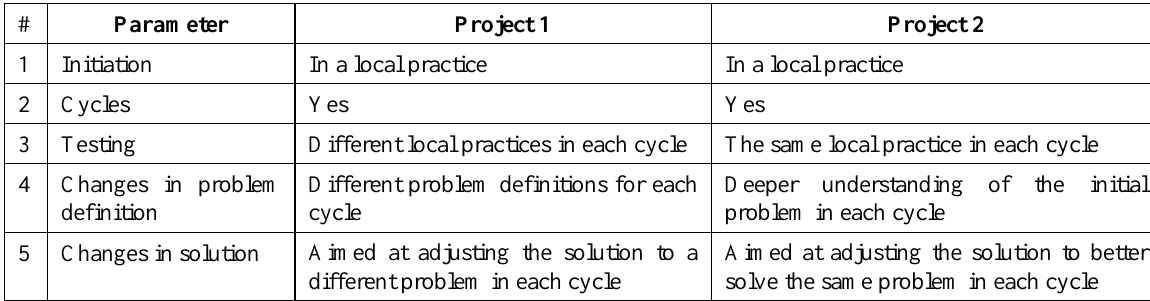
Table 1 . Results of projects